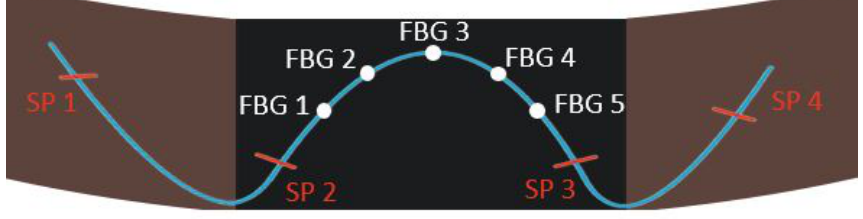
Figure 5. Fiber sewing points (SP 1, 2, 3 and 4) and FBGs position (FBG 1, 2, 3, 4 and 5) on the